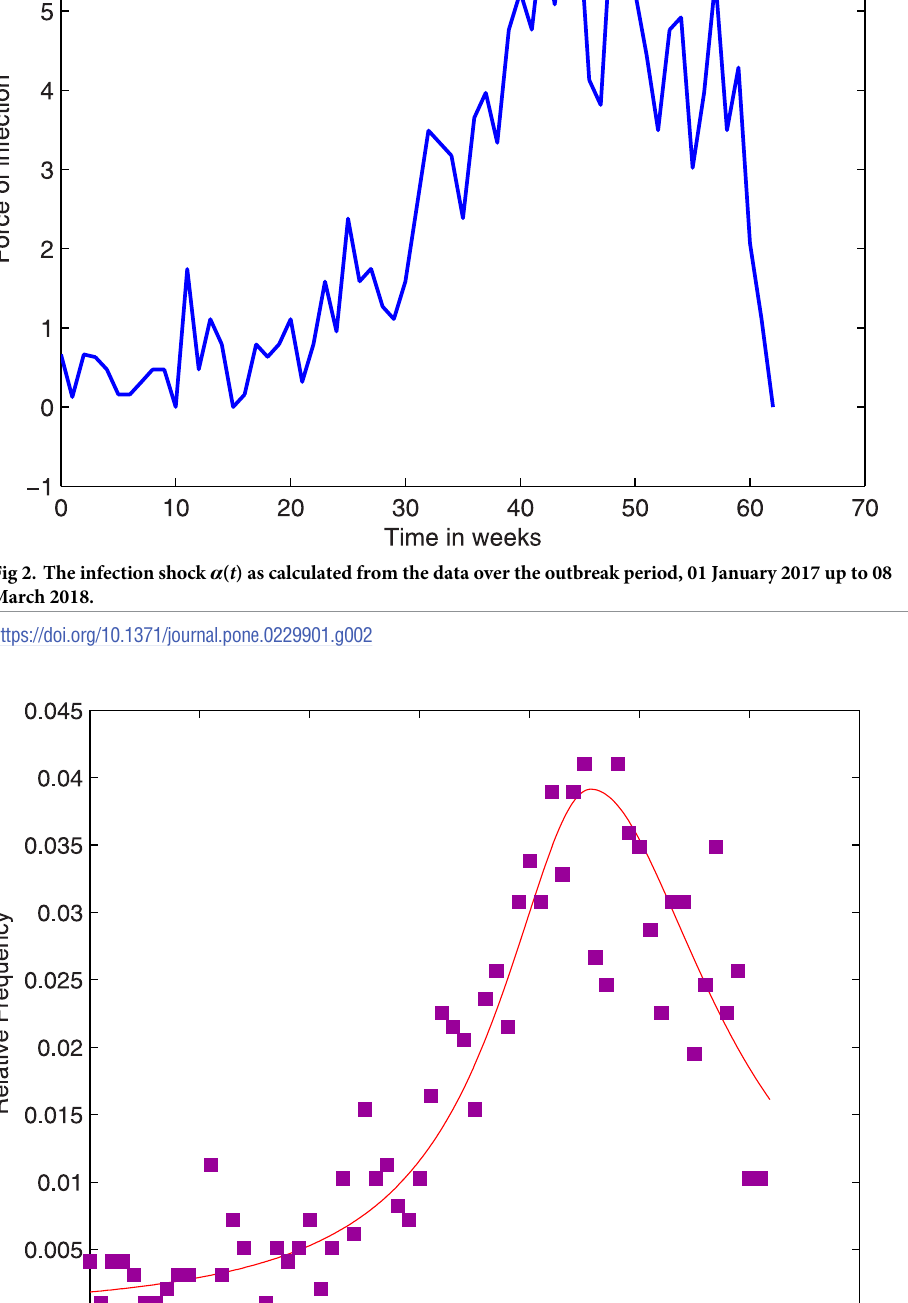
PLOS ONE | https://doi.org/10.1371/journal.pone.0229901 March 12,